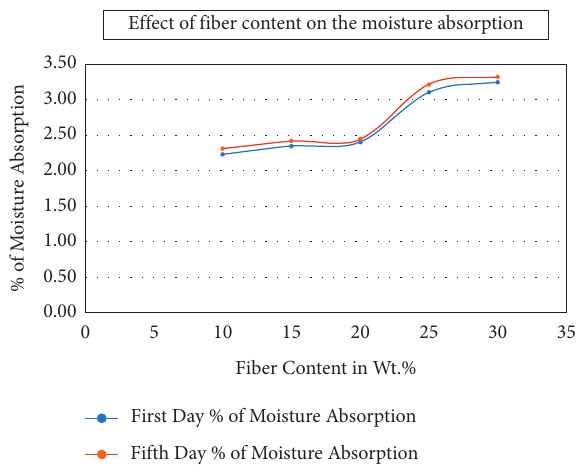
Figure 6: Water absorption of 140mm length of fiber composite with varying fiber